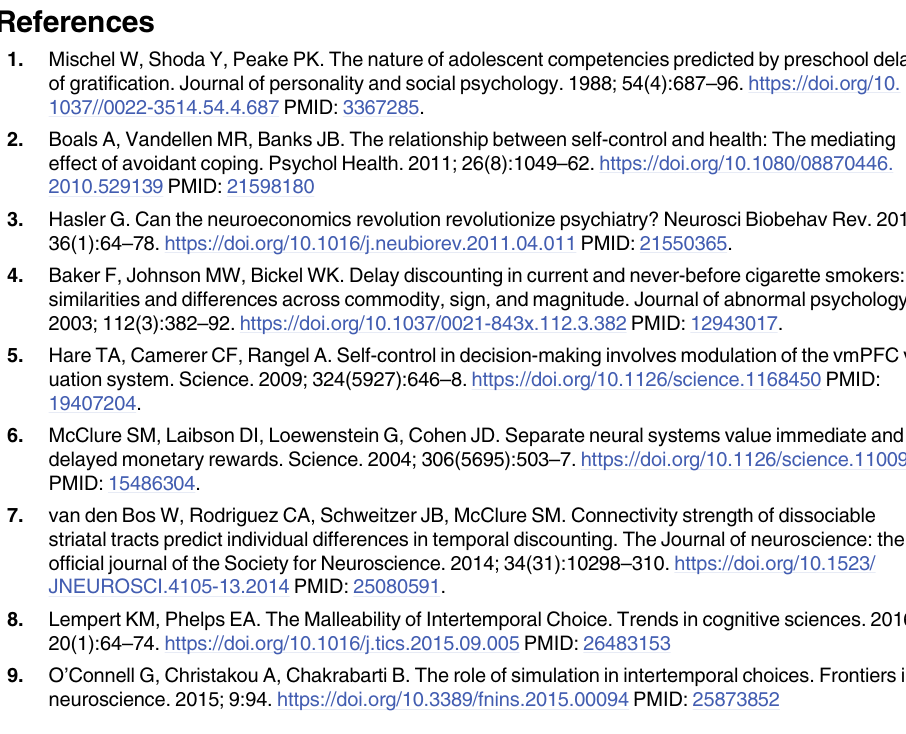
S2 Table. Anatomical locations showing cTBS effects on functional connectivity with the rTPJ. S3 Table. Anatomical locations correlating with events in the relative future compared to relative past in the mental time-travel task. S4 Table. Anatomical locations for cTBS effects on activation related to relative future compared with relative past